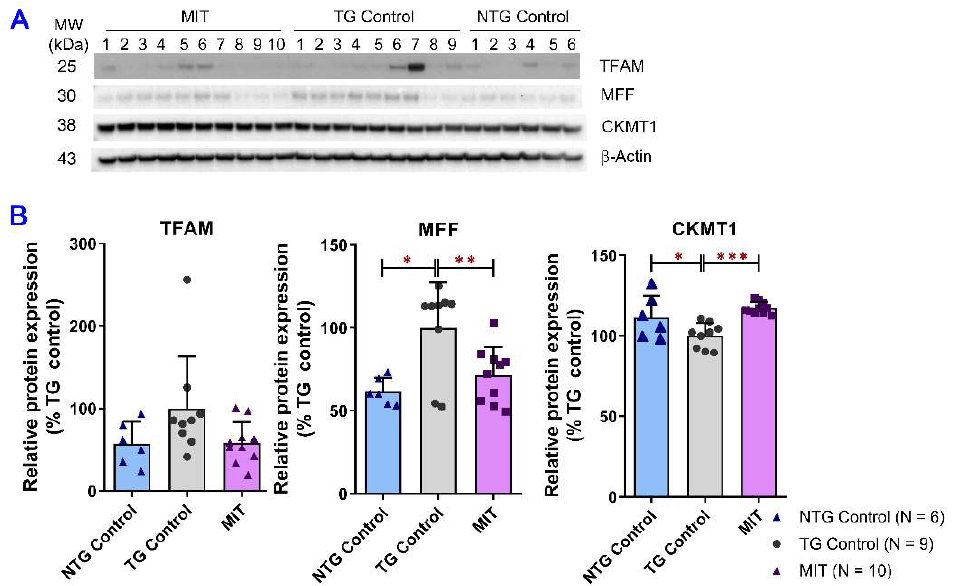
Figure 4. Evaluation of the MIT effect on the regulators of mitochondrial dynamics in the brain using semi-quantitative Western blot analysis. The brain tissue samples were collected from the TG and NTG control mice and TG mice treated with MIT for 3 months. ( A ) Representative immunoblots showing the expression of MFF, TFAM, and CKMT1 proteins in brain tissues collected from individual mice. ( B ) Densitometric analysis of the relative expression of MFF, TFAM, and CKMT1 proteins in brain tissues obtained from different study groups. There was a significant difference in the expression of MFF and CKMT1 proteins in NTG control ( p < 0.05 for both) and TG MIT treatment ( p < 0.01 and p < 0.001 for MFF and CKMT1, respectively) groups in comparison to the TG control group. The data are expressed as mean ± SD (N = 6 for the NTG control group, N = 9 for the TG control group, and N = 10 for the TG MIT treatment group). SD is denoted by error bars. * p < 0.05, ** p < 0.01, and *** p < 0.001 were compared between NTG control mice, TG control mice, and MIT-treated TG mice using a one-way ANOVA followed by a Tukey’s post hoc multiple comparison test.